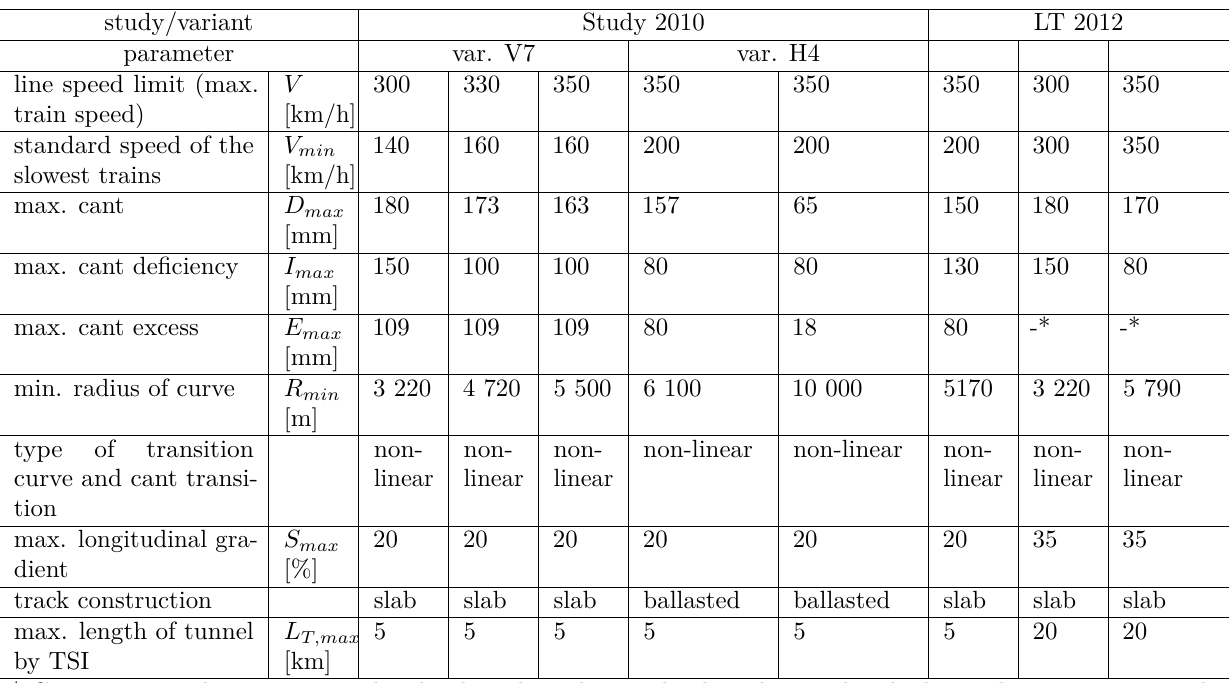
Table 1. Main design parameters of Study 2010 and LT